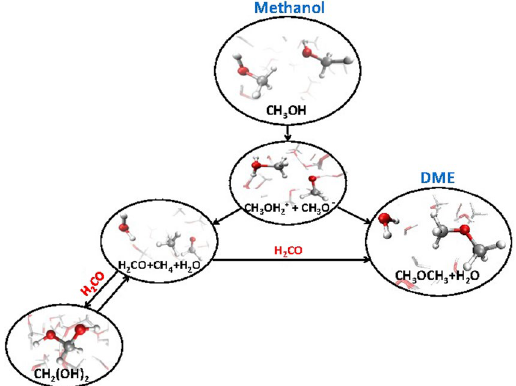
Figure 1. Methanol reaction network in presence of a static electric field. The application of this latter dissociates some methanol molecules (second panel from the top). Strengths above 0.50 V/Å are able to recombine the formed methanol cations and anions both into formaldehyde, methane, and water, both into DME and water (third panel from the top). Formaldehyde molecules will be further employed in order to synthesise also formaldehyde monohydrate (which has a strong tendency to dissociate) and DME.